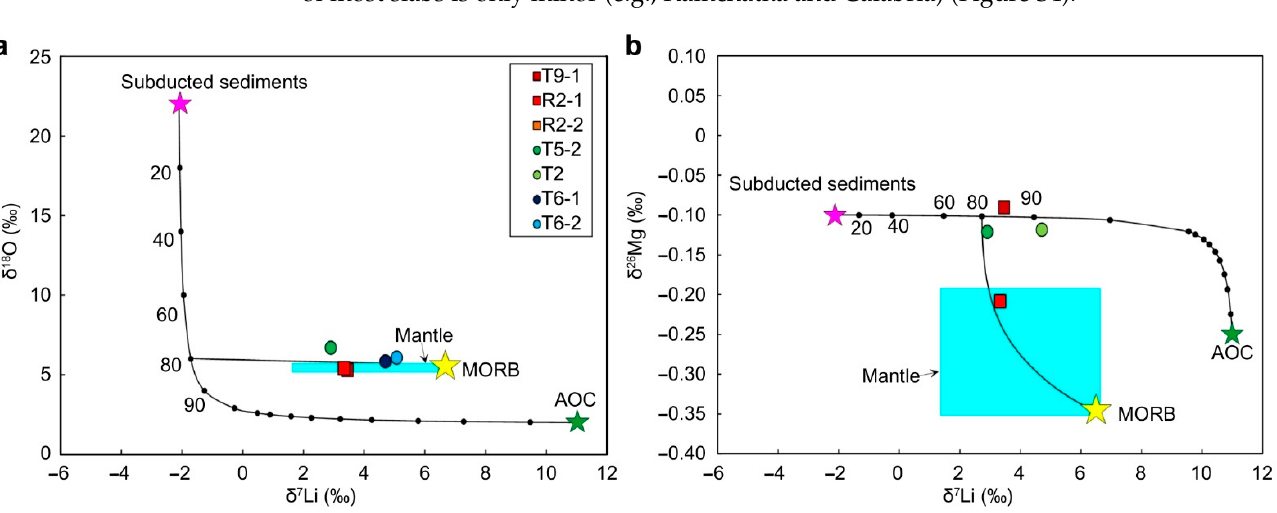
Figure 9. Plots of ( a ) δ 18 O vs. δ 7 Li and ( b ) δ 26 Mg vs. δ 7 Li for the MOT and SOT samples. Isotopic compositions ( δ 18 O = 2‰, δ 7 Li = 11‰, and δ 26 Mg = − 0.25‰) of AOC are from [33,39,137], respec- tively. Isotopic compositions ( δ 18 O = 22‰, δ 7 Li = − 2.1‰, and δ 26 Mg = − 0.1‰) of subducted sediments are from [7,33,108], respectively. Isotope compositions ( δ 18 O = 5.5‰, δ 7 Li = 6.5‰, and δ 26 Mg = − 0.35‰) of mid-ocean ridge basalts (MORBs) are from [22,107,110], respectively.